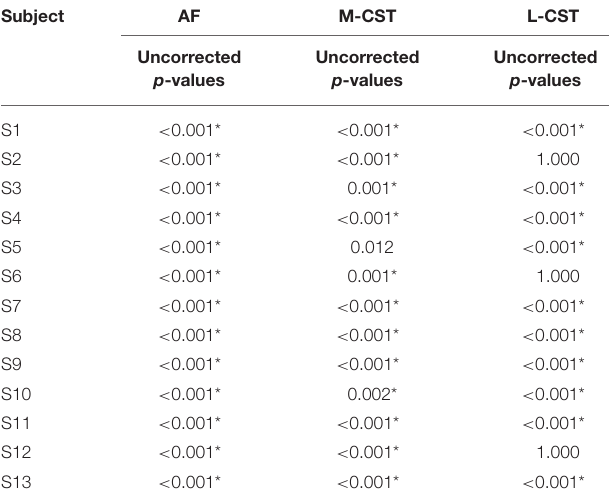
TABLE 4 | Relationship between AFD and